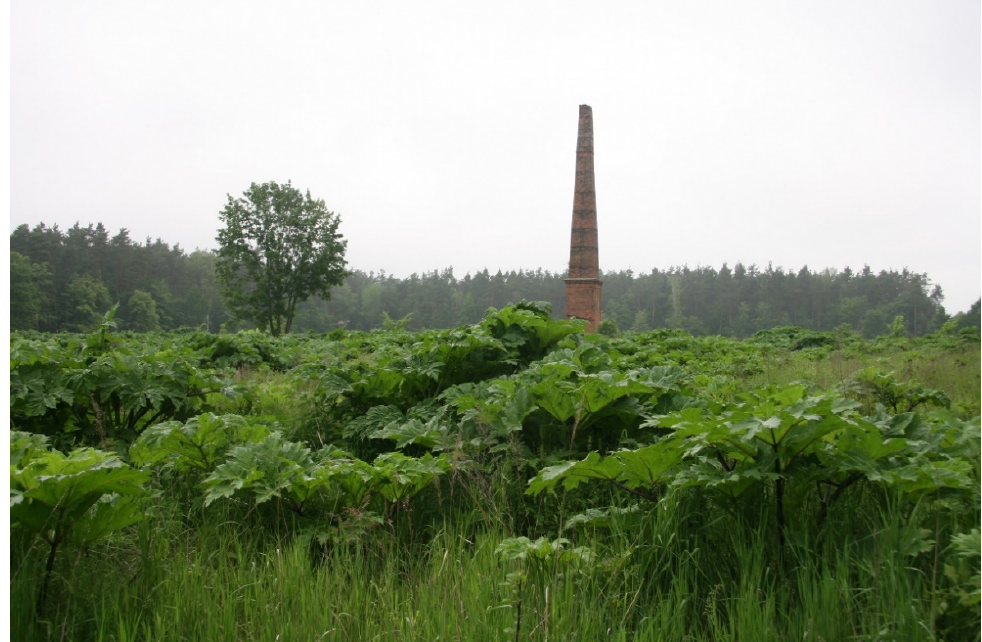
Figure 3. An example of a severely invaded area with Sosnowsky’s hogweeds growing in a monostad covering about 5 ha on the research site in south-eastern Poland (former crop near Koniecpol); invaders on the photograph were before flowering (date: 10 June 2020–author of photograph: E. Grz˛edzicka). Table 3. List of studies that identified impact of Caucasian hogweeds on biodiversity